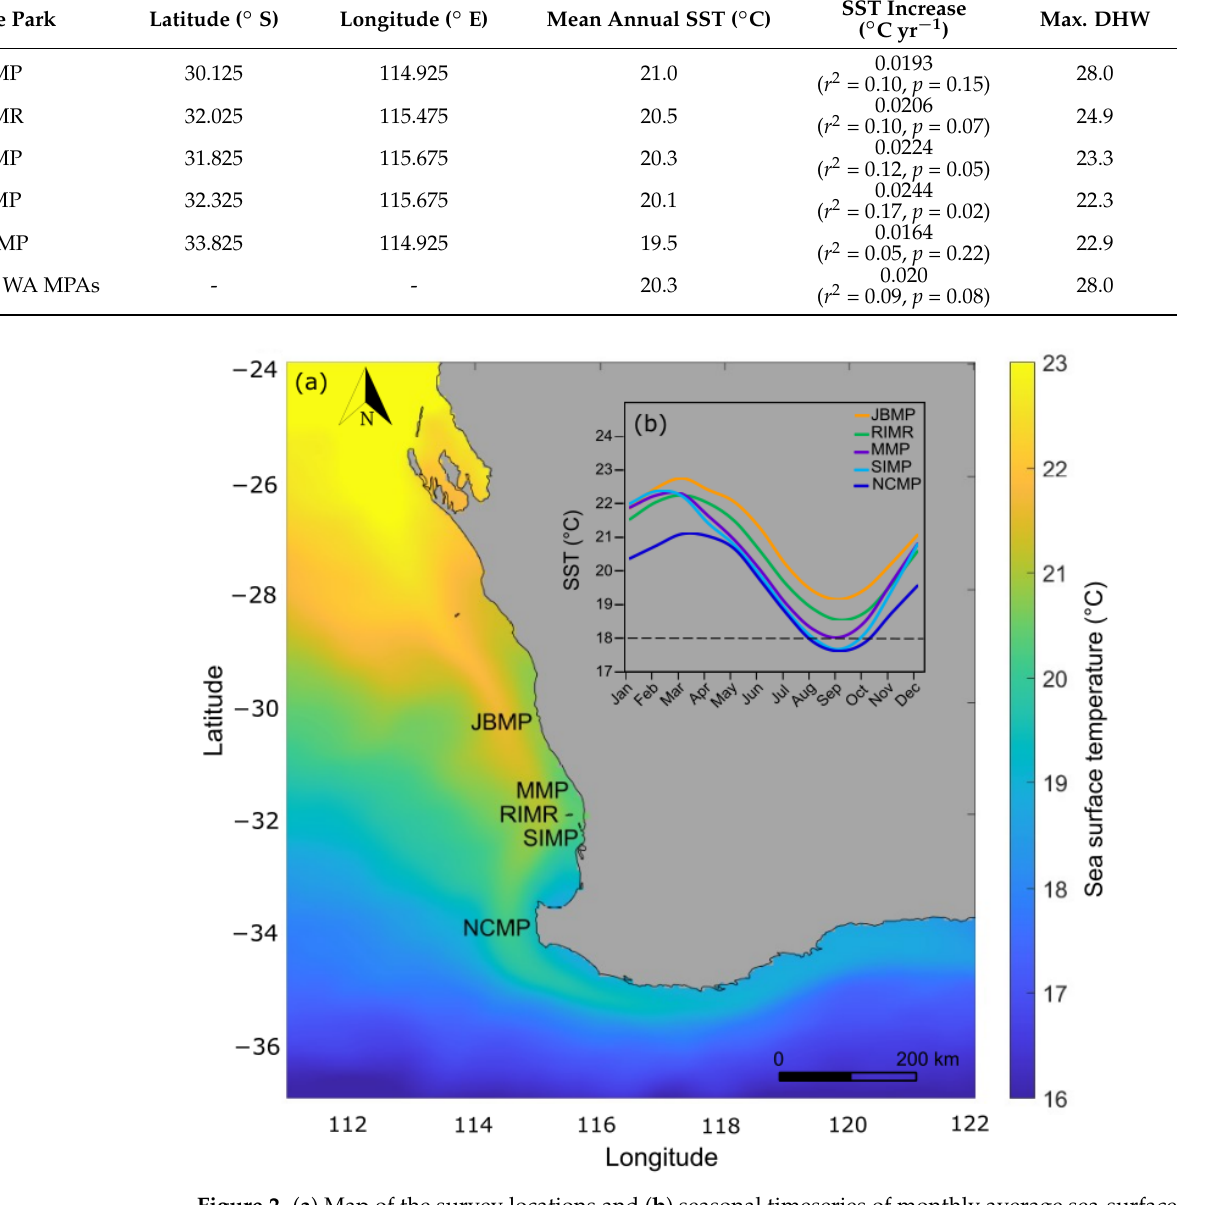
Figure 2. ( a ) Map of the survey locations and ( b ) seasonal timeseries of monthly average sea-surface temperature (SST) profiles for Jurien Bay Marine Park (JBMP), Marmion Marine Park (MMP), Rottnest Island Marine Reserve (RIMR), Shoalwater Islands Marine Park (SIMP), and Ngari Capes Marine Park (NCMP), which span a latitudinal gradient in sea-surface temperature (SST) along the West Australian coast. The spatial interpolation is the annual average SST for 2019 and the seasonal SST timeseries are the monthly means for 1986–2019. Data source: NOAA Coral ReefWatch 5 km SST (NOAA, 2021).